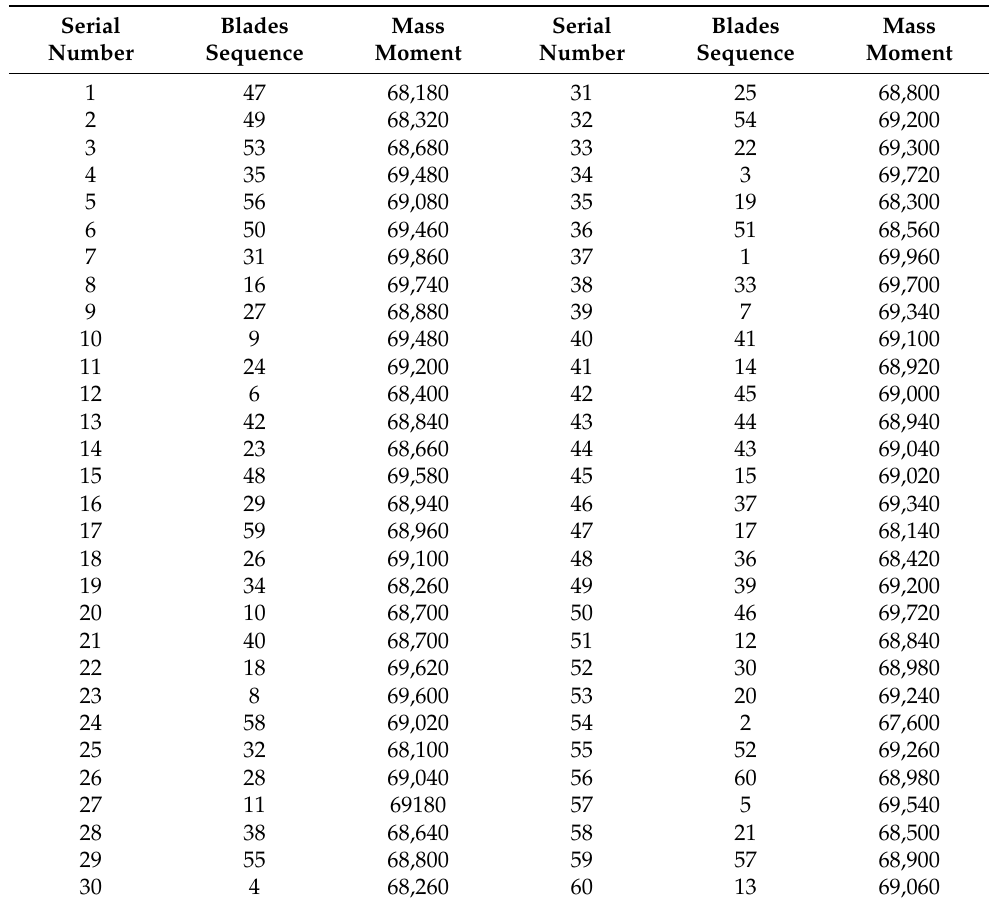
Figure 5. Second-level blade sorting results. Table 4. Order table of secondary blades.